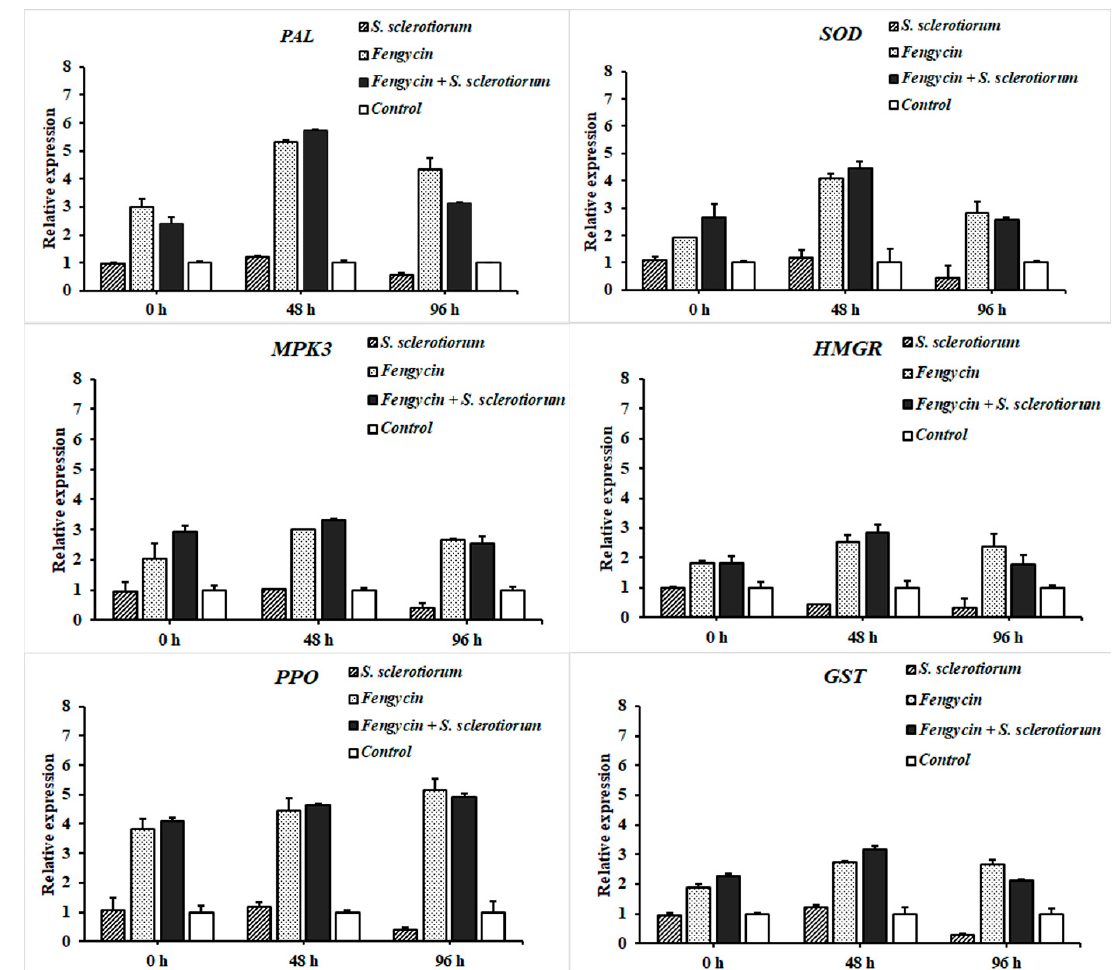
Figure 9. Expression profiling of six defense-related genes in tomato plants at 0, 48, and 96 h post-inoculation. Mean values were analyzed and separated by Tukey’s HSD test at p ≤ 0.05 after one-way ANOVA. Error bars represent standard error ± SE of the mean.